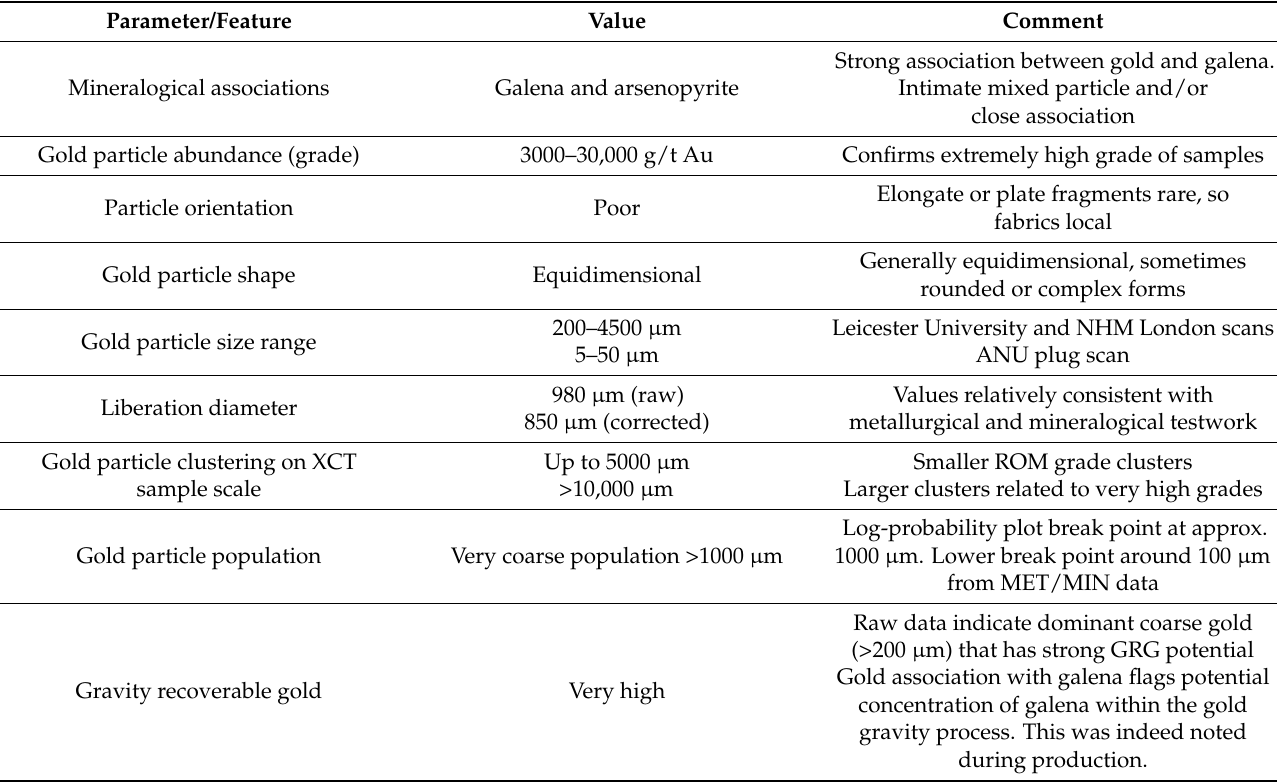
Table 15. Summary of gold particle parameters from